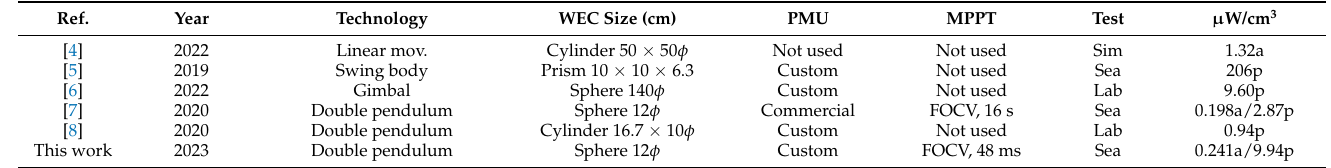
Table 4. Results for electromagnetic-based, small-size WEC, harvesting energy from free floating buoys. The table includes the PMU used and the results achieved.